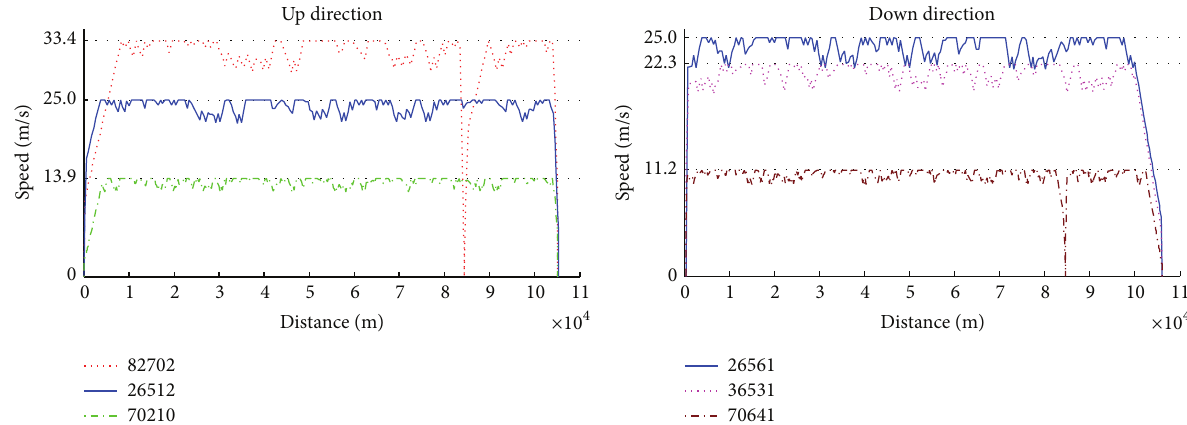
Figure 21: Train speed-distance curve (NCBS: blocking sections 4 and 5 in the